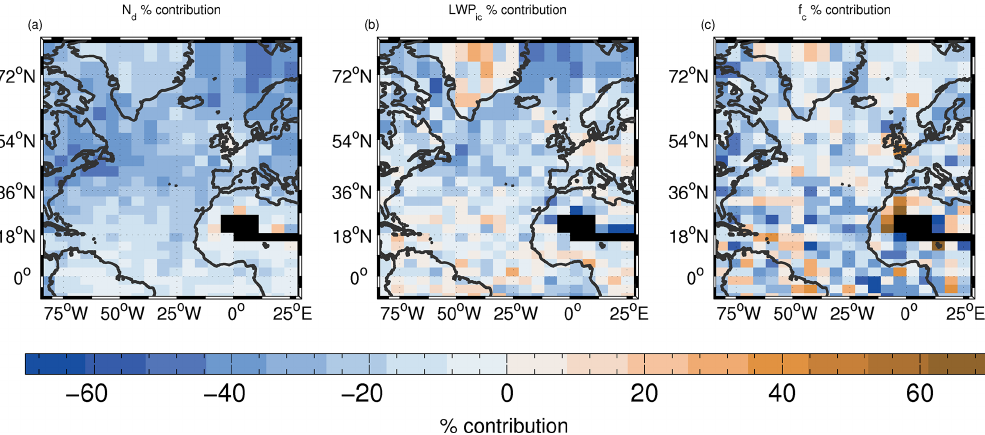
Figure 16. The percentage of the sum of the absolute contributions to the ACI forcing for the terms in Fig. 15. See Eq. (4). Note that the absolute values of the percentages for each grid box add up to 100%.